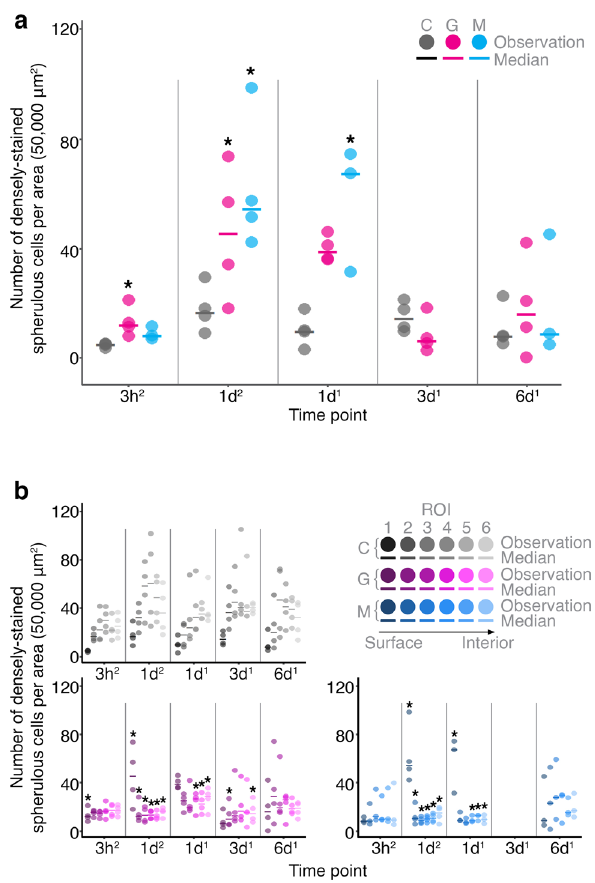
Figure 3. Time-dependent re-distribution of spherulous cells upon wounding. Number of densely-stained spherulous cells per area (50,000 μm 2 ) right at the surface (first 100 μm) ( a ) and within the first 600 µm ( b ). Spherulous cell density in grazing and mechanical damage were compared to the control at each Region Of Interest (ROI, each defined by a depth of 100 µm, starting from the surface, ROI 1, consecutively to the interior ROI 6). Note that there was no mechanical damage group at 3 days. Superscript number 1 and 2 denotes experiments performed in 2016 and 2017, respectively. Star indicates statistically significant differences. C control; G grazing; M mechanical